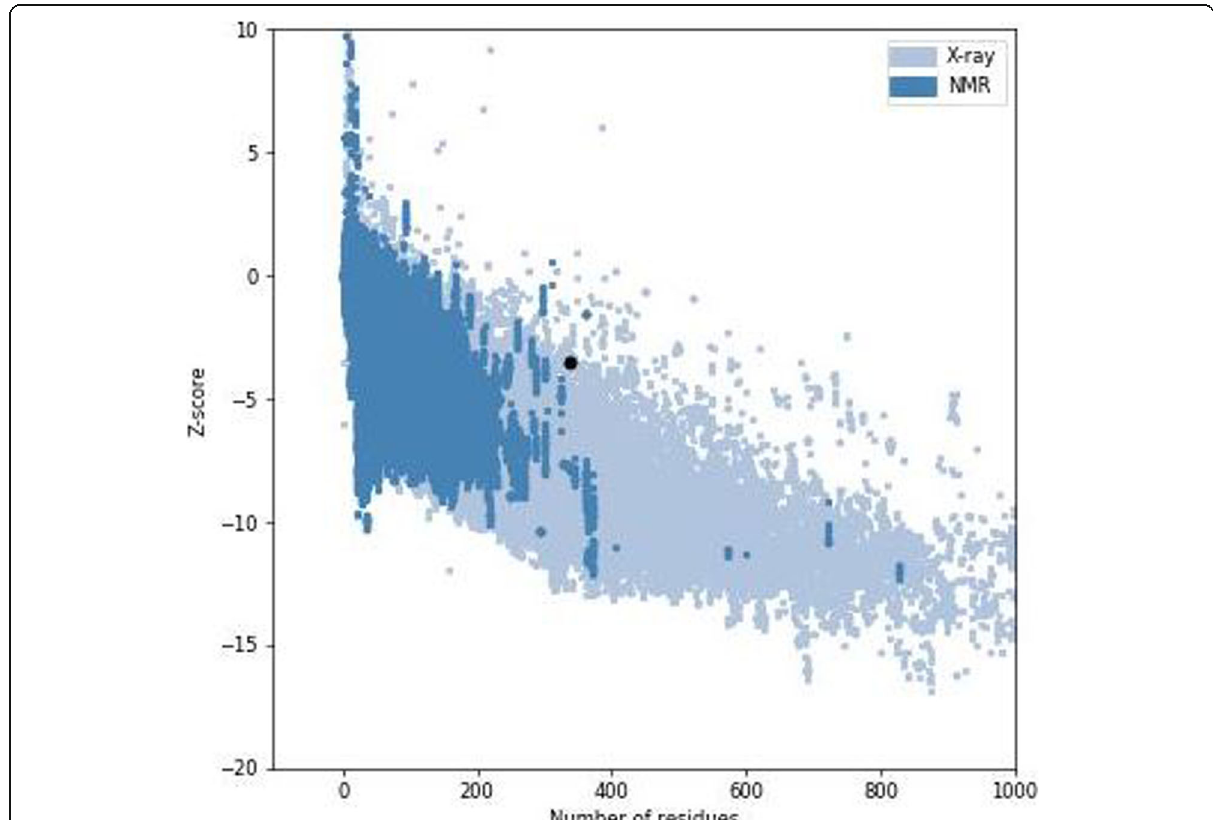
Fig. 6 Z score of the model of the vaccine model developed by